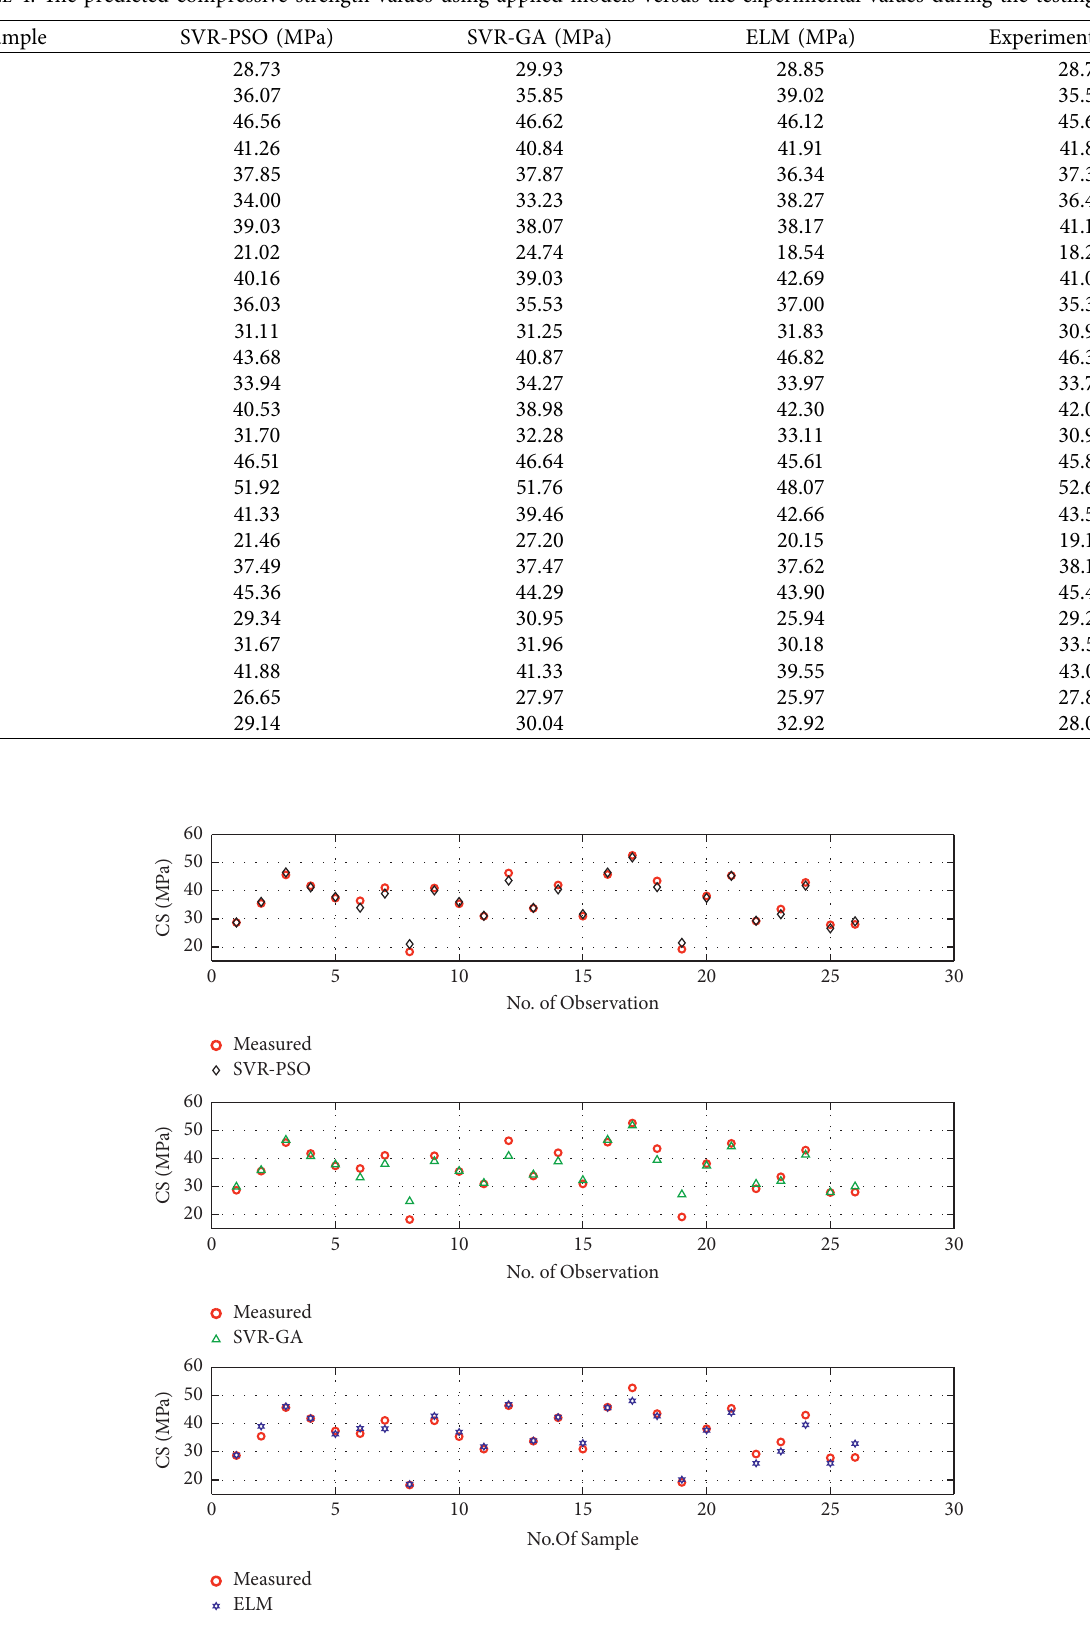
Figure 7: Comparison between the measured compressive strength of concrete and the predicted